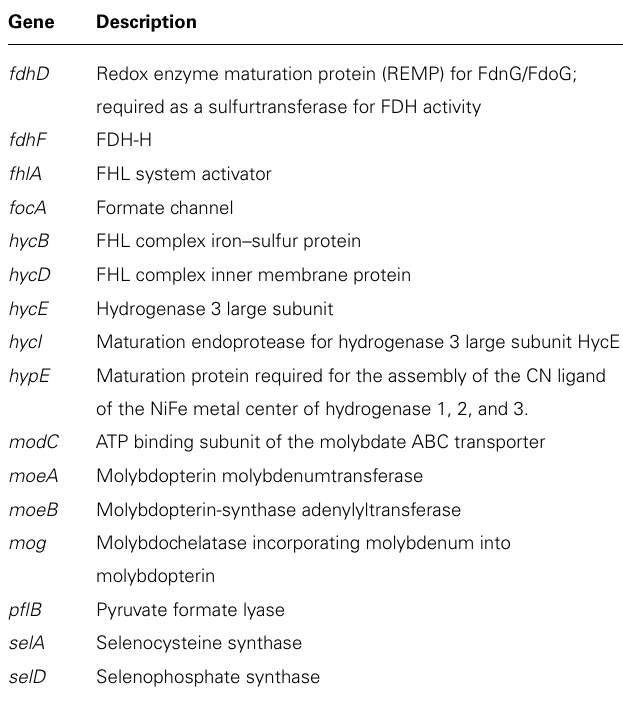
Table 3 | List of genes knocked out in transposon insertion mutants of E. coli MG1655 containing pTrc99A-P trc - budAB that had lost the stationary-phase deacidification capacity but still produced acetoin (MR + /VP +